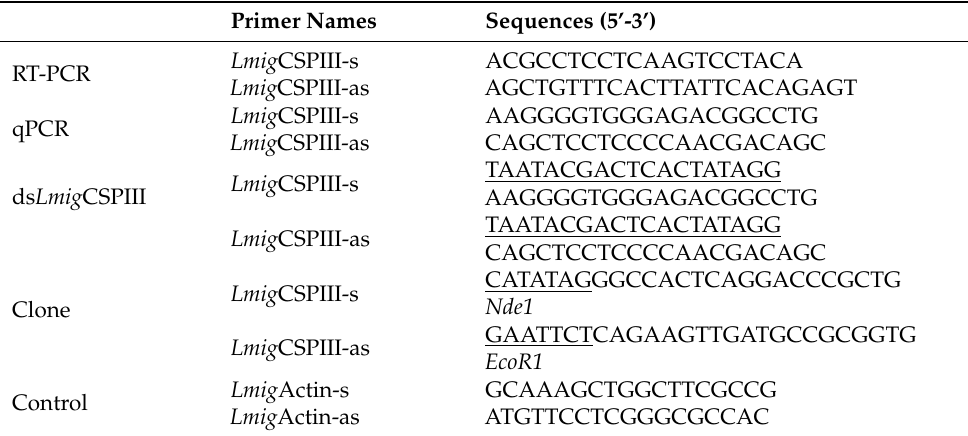
Table 1. Specific primers used in this